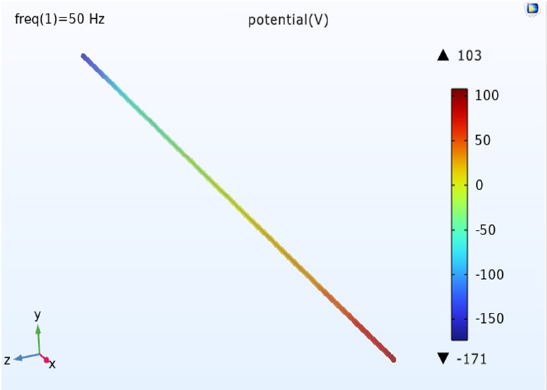
Figure 27. Distribution of cathodic protection potential at 6 m burial depth.